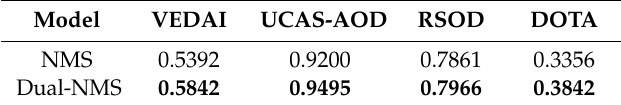
Table 3. Comparison of the F 1 score for the dual-NMS in di ff erent data sets (The best result in each dataset is marked in bold).